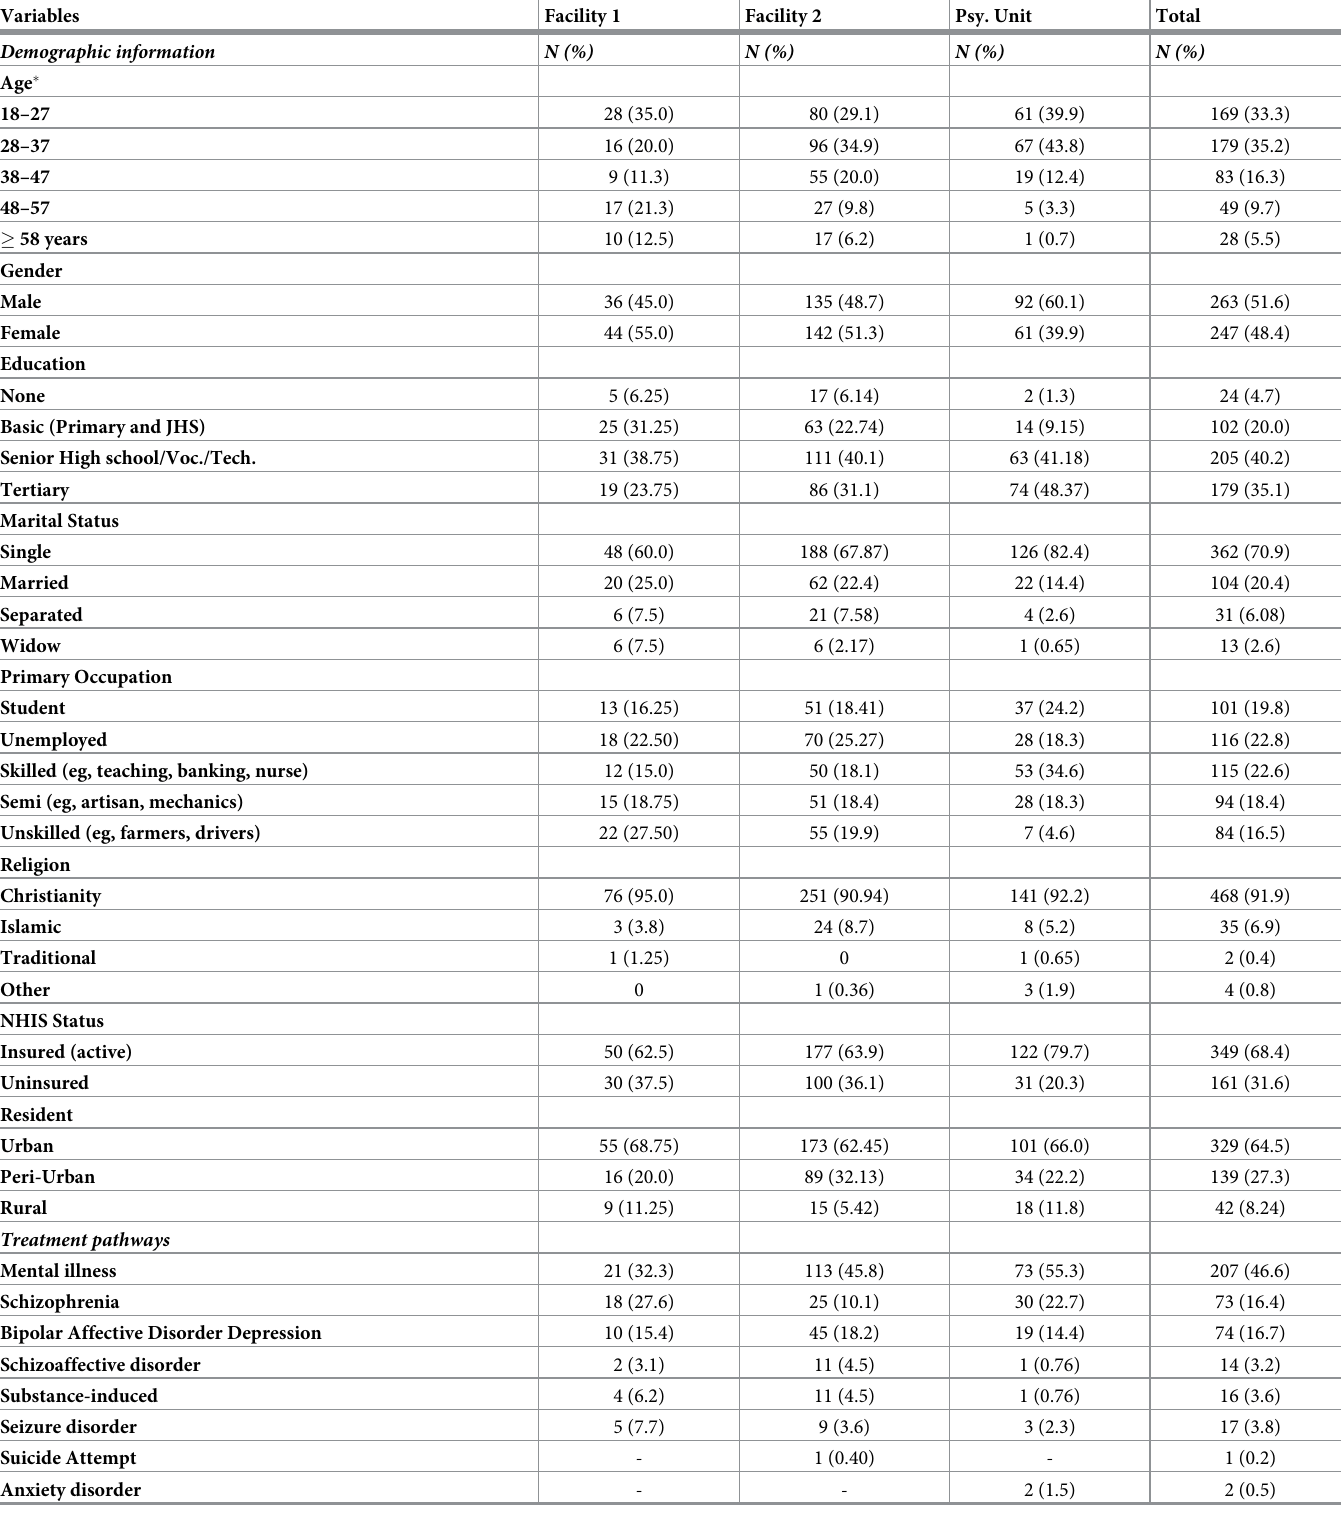
Table 1. Characteristics of